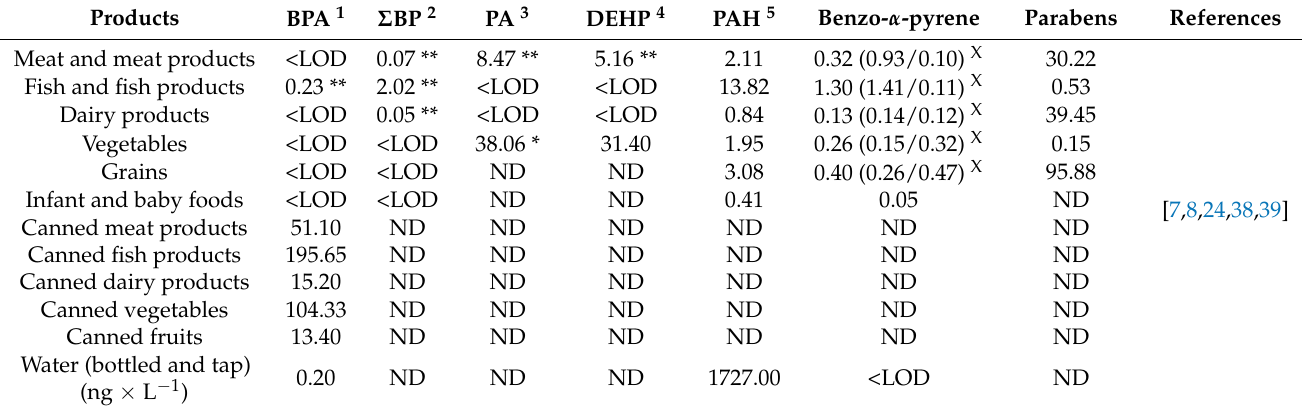
Table 2. Levels of selected EDCs in food (ng × g − 1